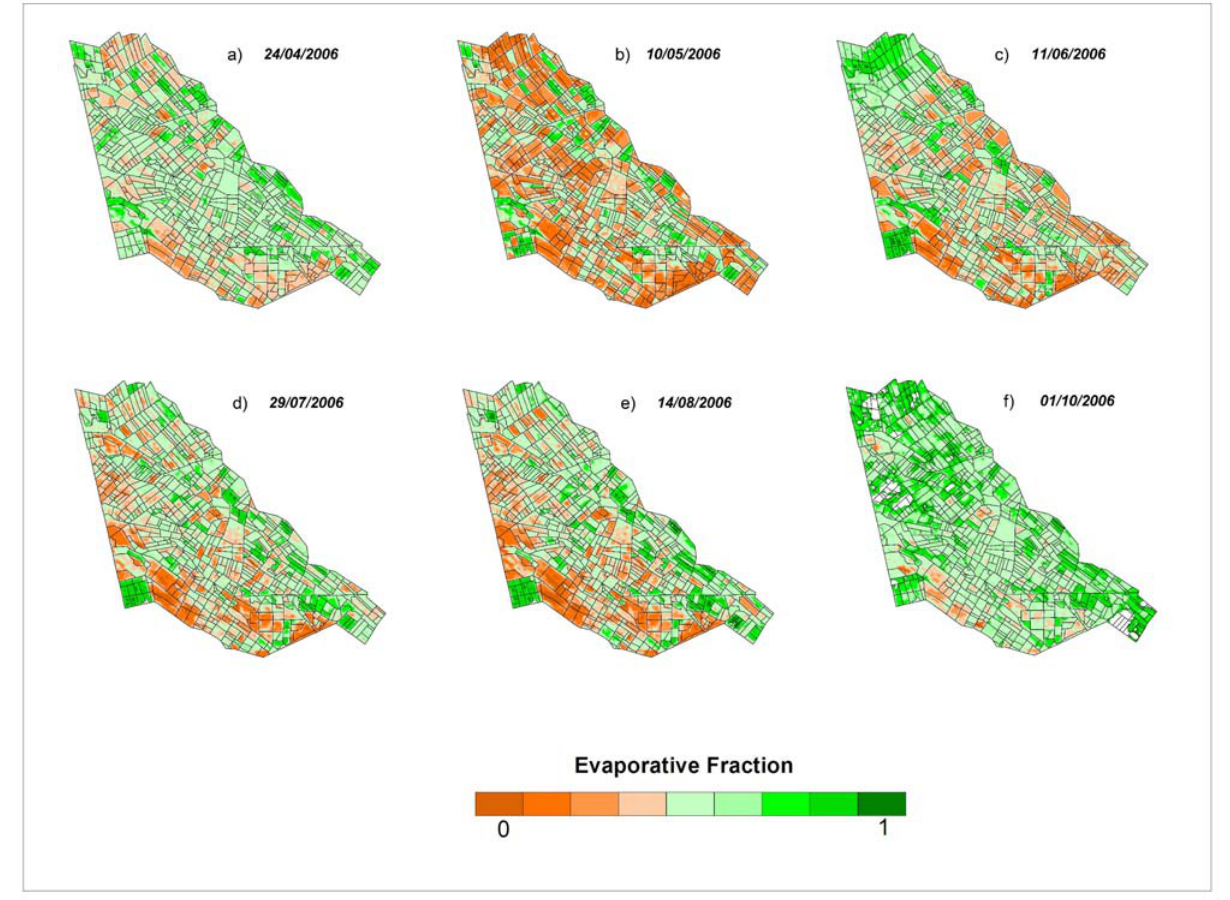
Figure 8. Seasonal changes of ET fraction, derived using thermal band of Landsat ETM+ for the Galaba study area during